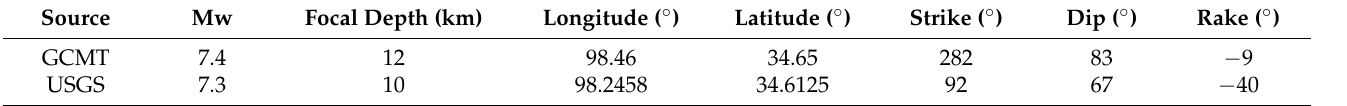
Figure 2e,f show the coseismic displacement fields in the ground range direction resolved by the offset tracking method, and the incoherent regions to the west of the